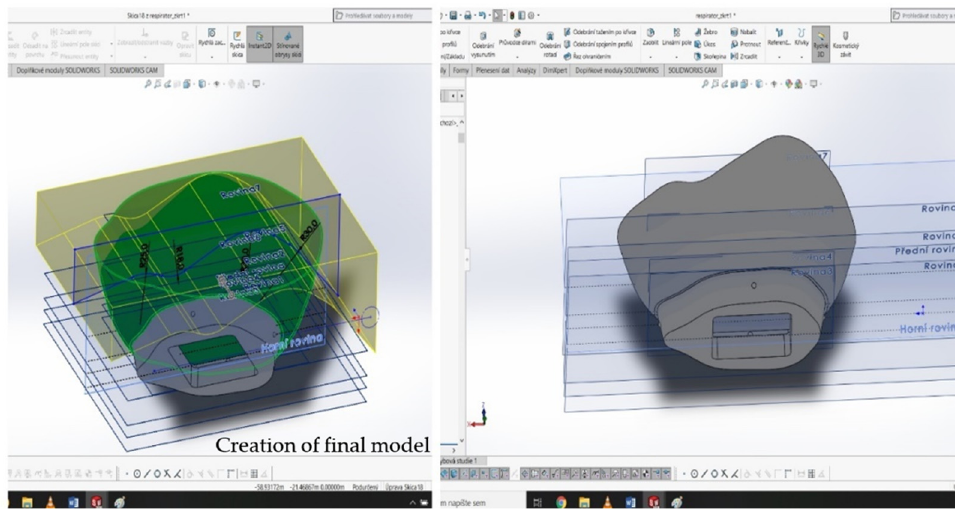
Figure 7. Carving the outside—view from below.